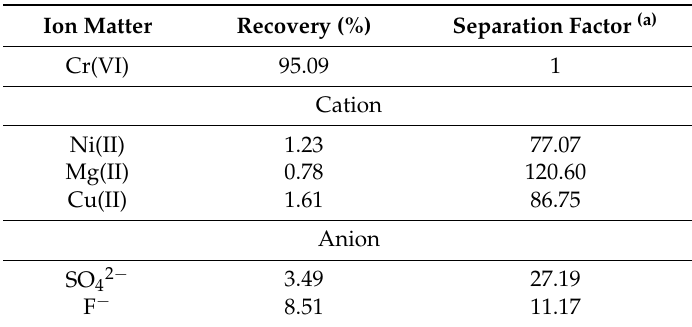
Table 4. Separation of Cr(VI) from mixture solution by Aliquat 336/PolyHIPE membrane. Ion Matter Recovery